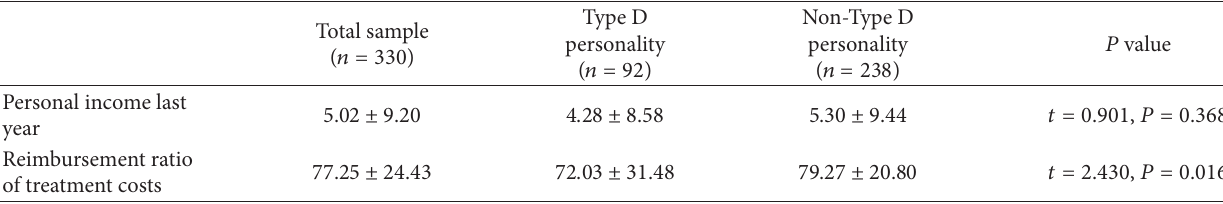
Table 1: Sample characteristics.